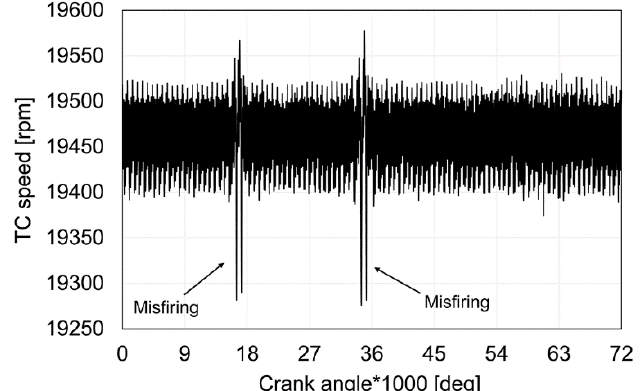
Figure 24. Instantaneous TC speed signal for 100 consecutive cycles with a misfiring imposed for two consecutive cycle in the cylinder 1. Engine speed 1000 rpm at low load.